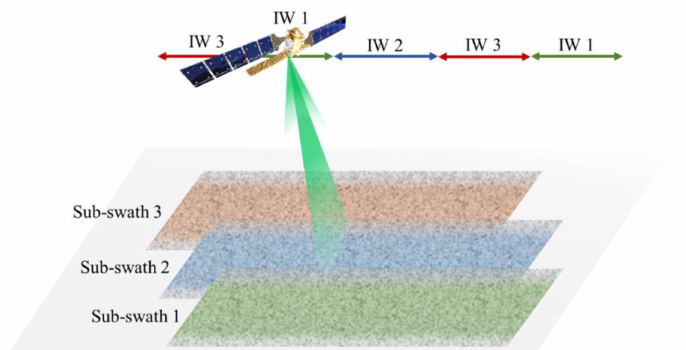
Figure 1. The scanning process in the IW mode of Sentinel-1 using the TOPSAR technology, where each sub-swath corresponds to individual IW signal, designated by IW 1, IW 2, and IW 3.